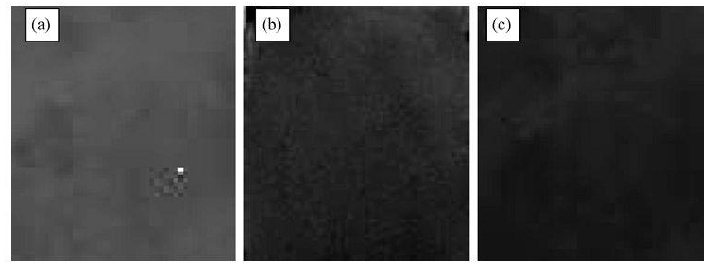
Figure 14. Color changes of TiO irradiation for 1 h and (c) after irradiation for 2 h [33]. Reproduced with permission from Elsevier, © 2009.